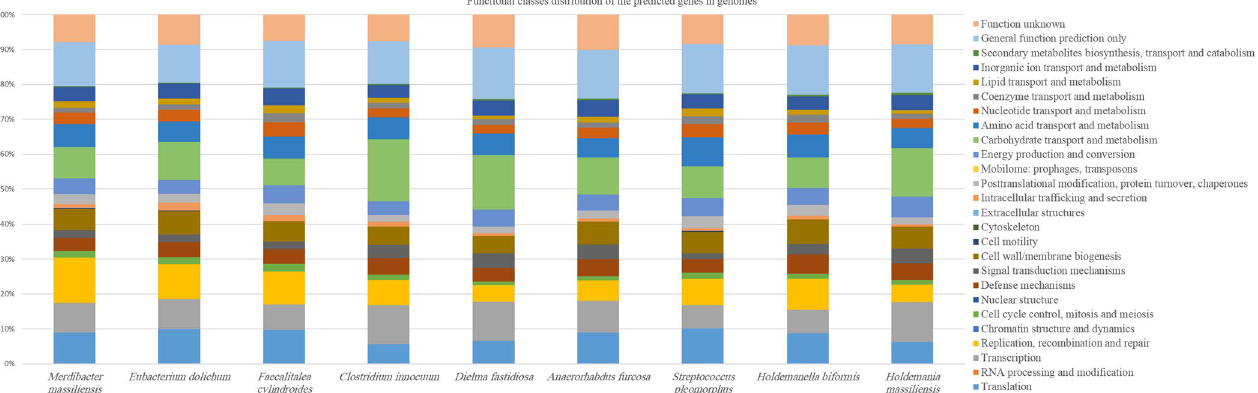
Figure 5. Distribution of functional classes of predicted genes according to the clusters of orthologous groups of proteins of Merdibacter massiliensis gen. nov., sp. nov., strain Marseille-P3254 and other compared bacterial taxa.